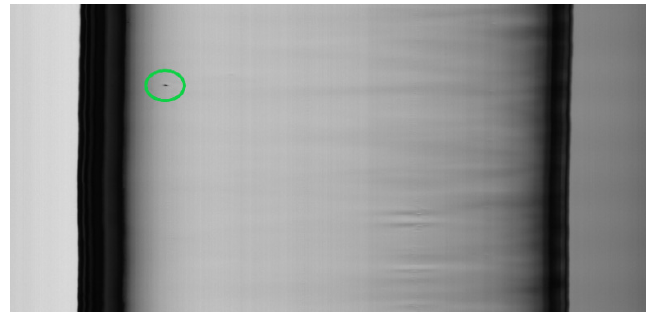
Figure 4. A blob defect (enclosed in a green oval). The tube has a more similar shape to a “sausage”, as can be seen on the center and right side. as can be seen on the center and right